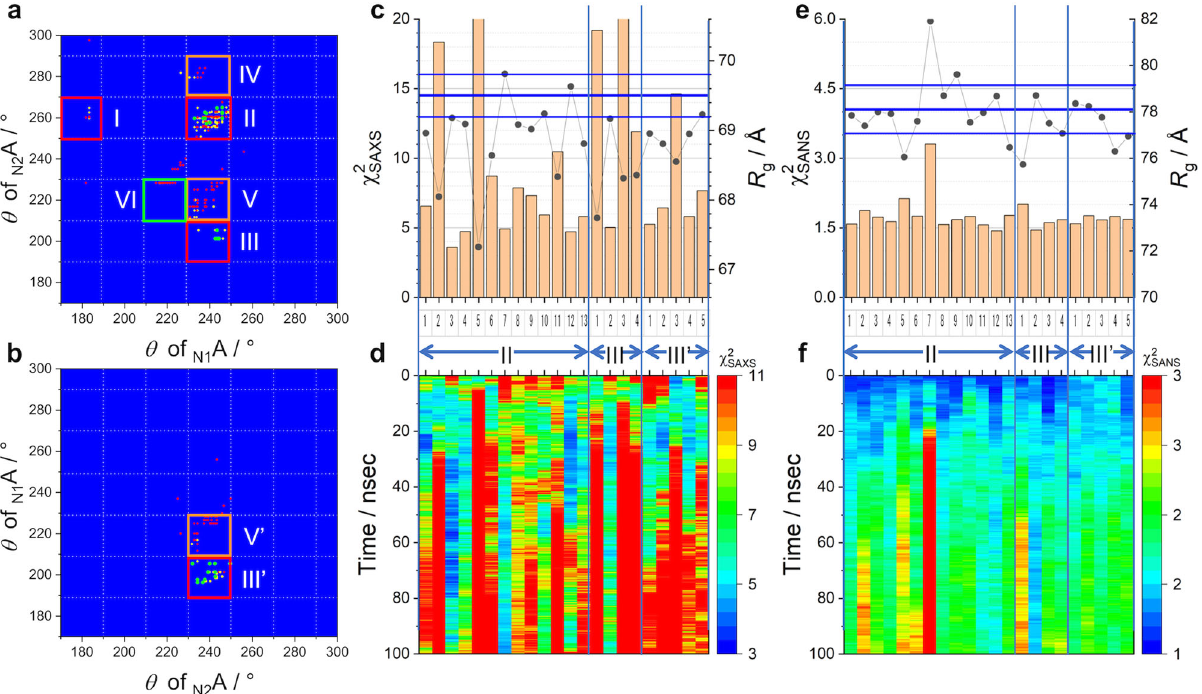
Fig. 4 10 ns MD screening of selected models in eight groups and 100 ns MD veri fi cation of survived models (Model II-1 to II-13, III-1 to III-4, III ’ -1 to III ’ -5). a , b Distribution map of N A domains in the models after 10 ns MD simulation: a Groups I – VI and b Groups III ’ and V ’ . Color denotes χ 2 MD simulation. Green, yellow, and orange dots correspond to the structures with χ 2 MD simulation for 22 models. In each panel, numbers of horizontal axis indicate codes of models corresponding to Table 1. c χ 2 circles) for the SAXS pro fi les averaged over the simulation time (100 ns). d Time evolutions of χ 2 (black circles) for the SANS pro fi les averaged over the simulation time (100 ns). f Time evolutions of χ 2 thick blue lines show the experimental R g values and thin blue lines express the ranges of their